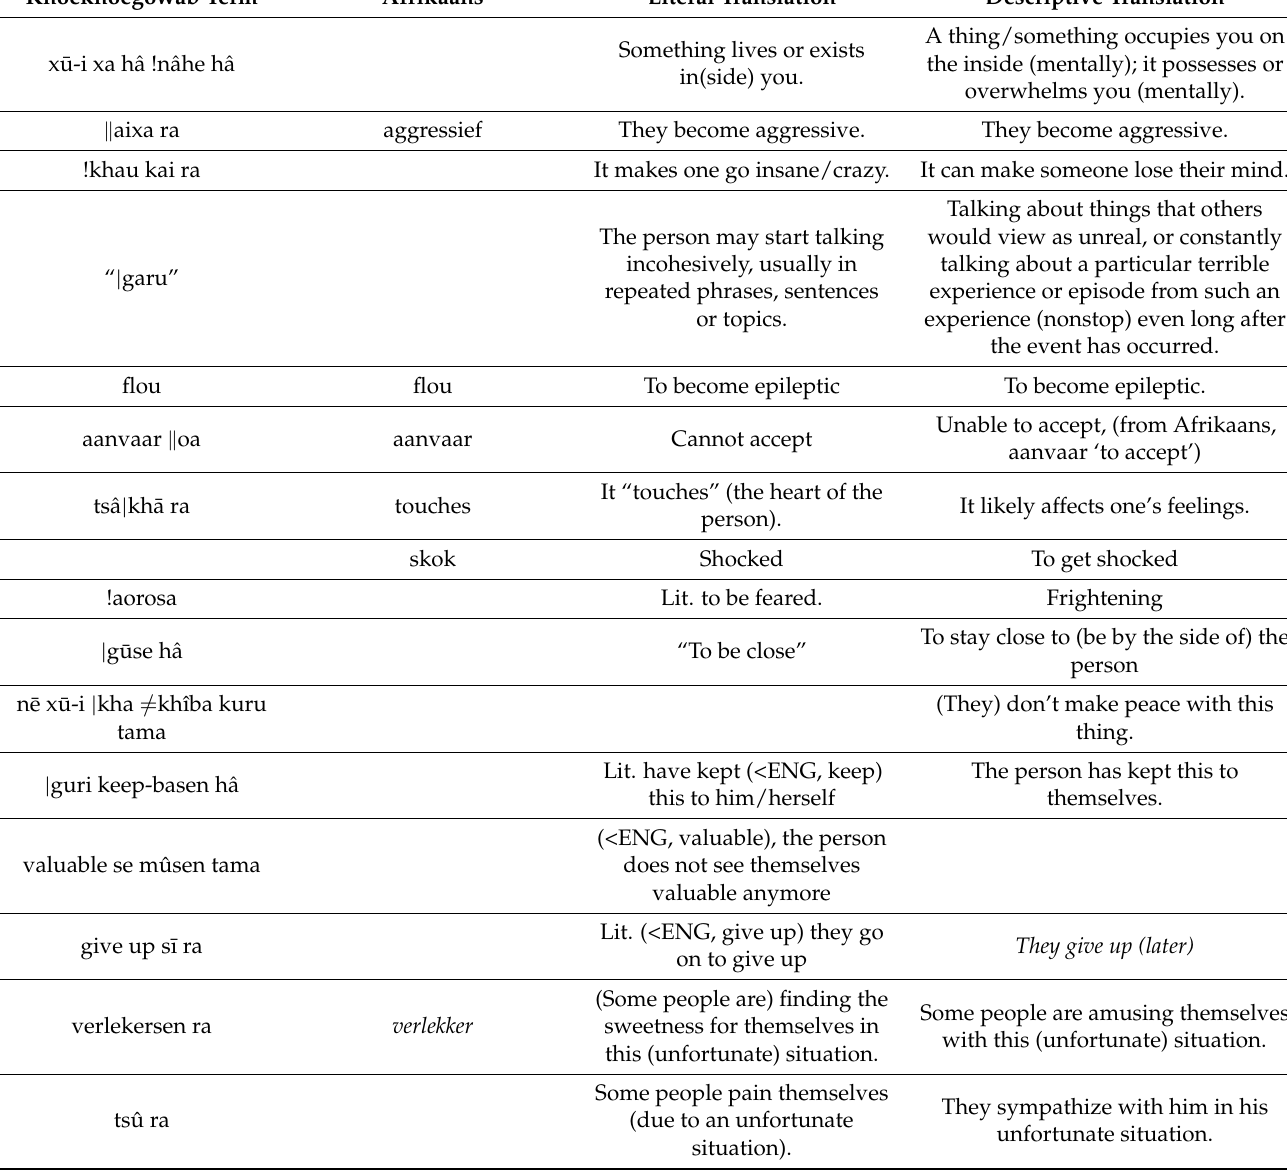
Table 1. Khoekhoegowab and Afrikaans Expressions Relevant to Depictions of Tsûsa !Nae!khais